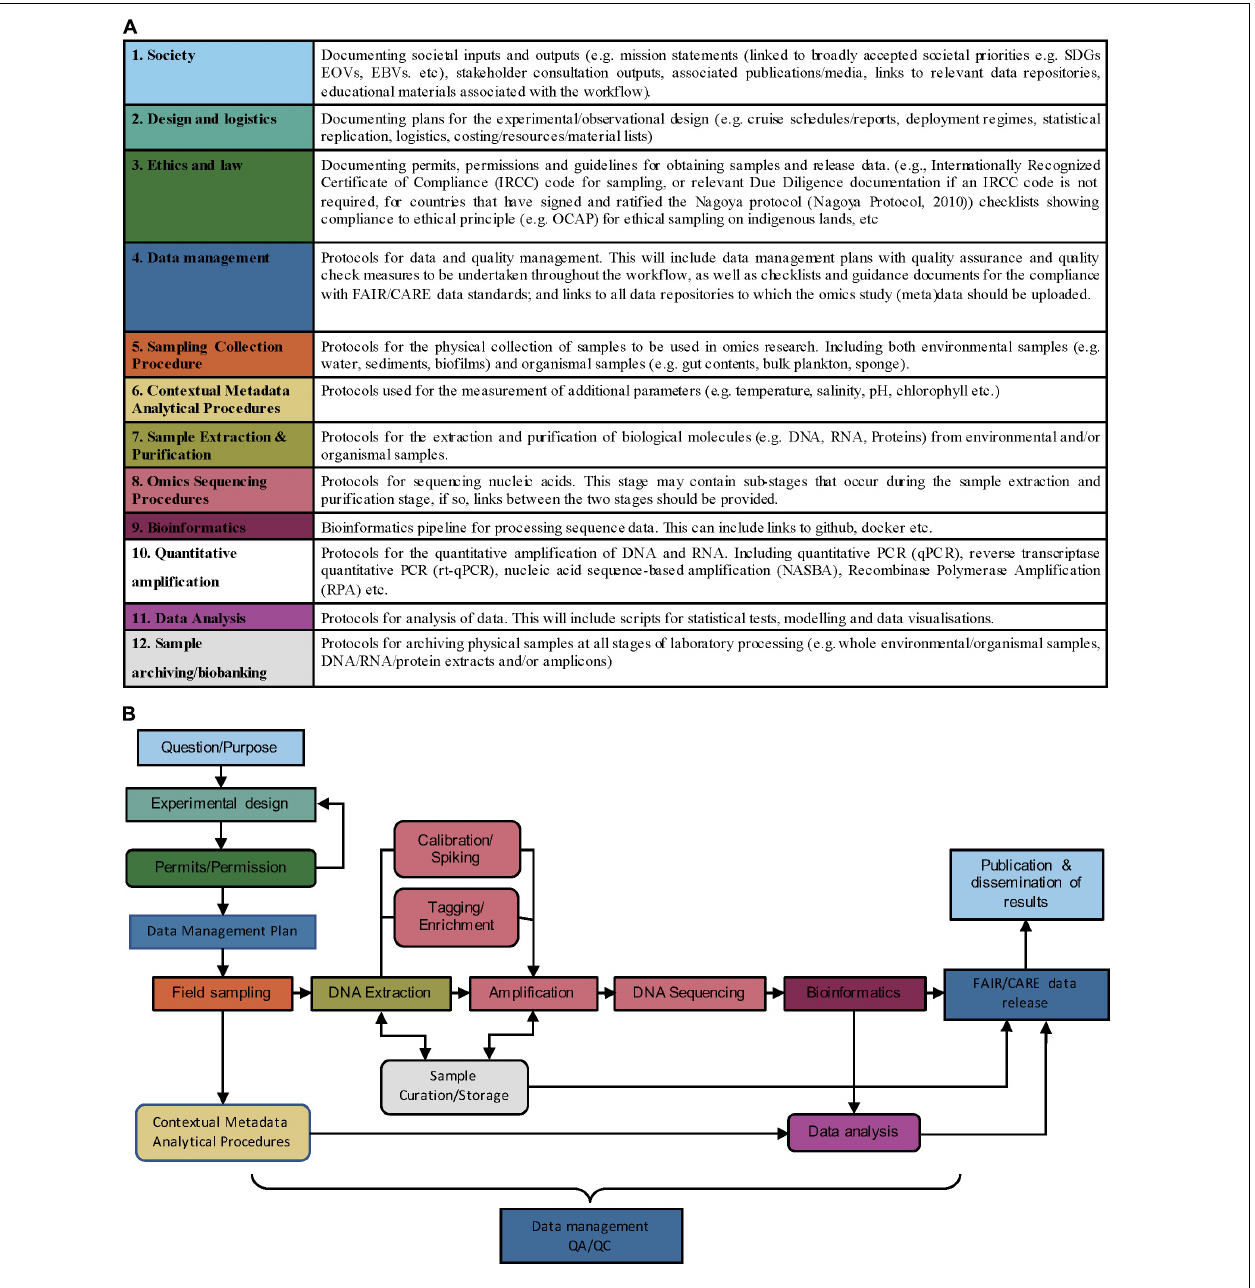
FIGURE 1 | (A) Proposed methodology categories to enhance exchange of ocean omics analysis knowhow. Protocols, guidelines, and other methodologies in some of these categories (such as Sample archiving/biobanking, Data Management, and Society) are cross-cutting and may apply at multiple points in the workflow. (B) Example workflow for a DNA metabarcoding project. Colors correspond to the methodology categories outlined in panel (A) and arrows indicate the order of the workflow. Square boxes show essential steps in a metabarcoding workflow, whereas rounded boxes indicate non-essential steps. Data management and QA/QC are required throughout the entire